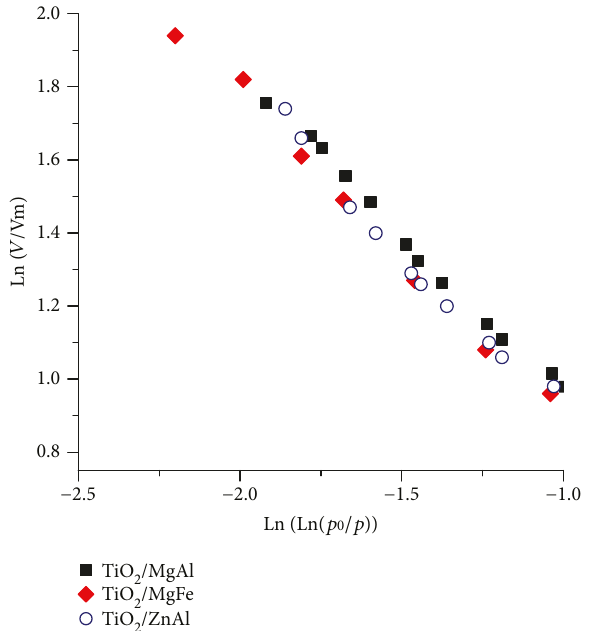
Figure 5: Linearization of N Frenkel – Halsey – Hill equation for TiO